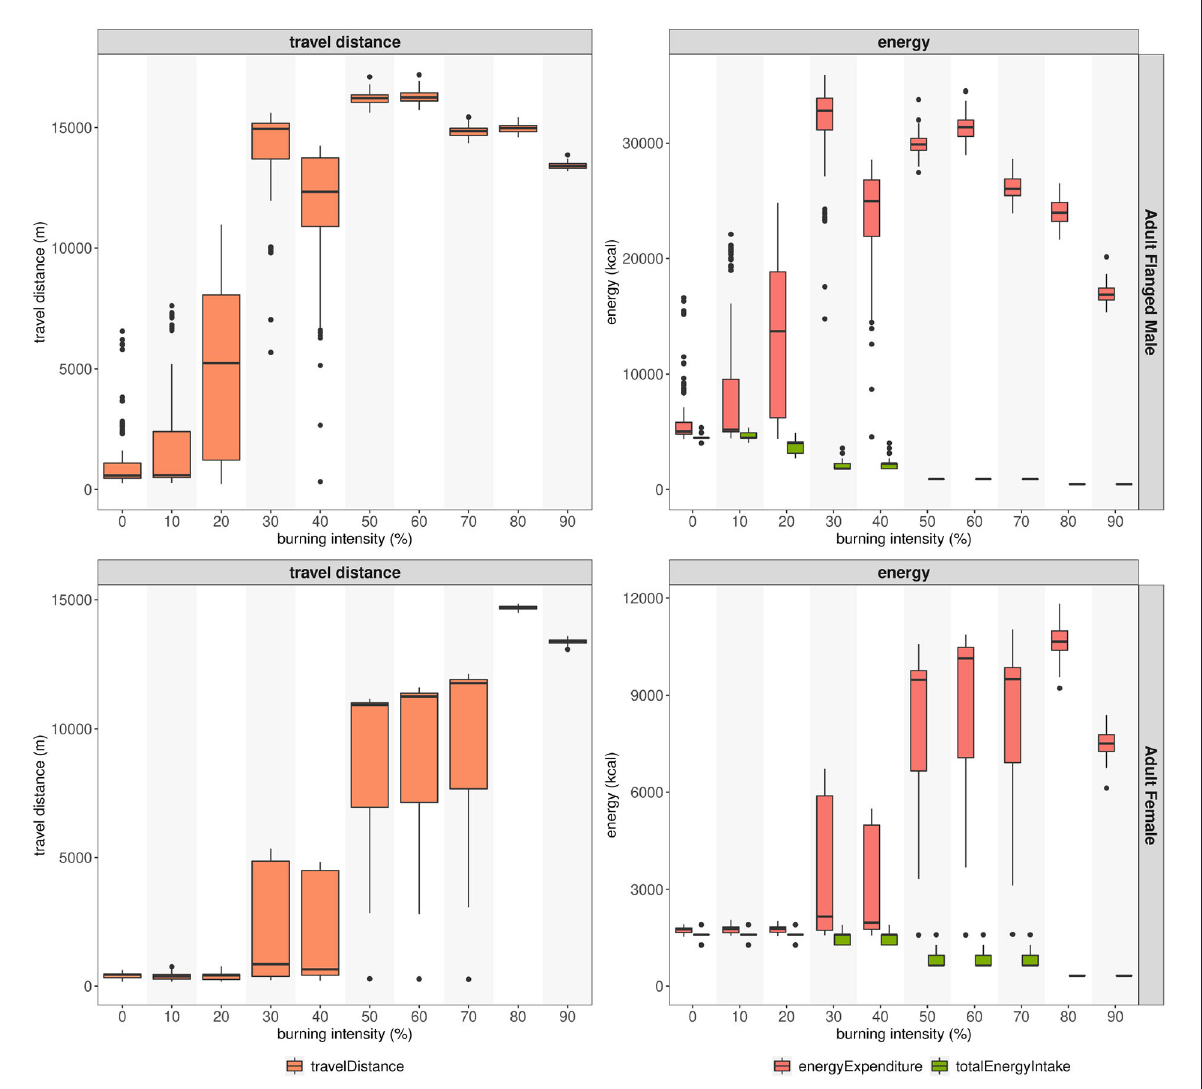
FIGURE8 Scenario test with the calibrated model for adult flanged male and adult female visualized in box-plots. The length, center mark, and edges of each box show the interquartile range, median, and quartiles Q1/Q3 of the sampled simulation output, respectively. The model is initialized with the parameter set referring to Table 3. The number of trees and fruiting trees refers to Supplementary Table